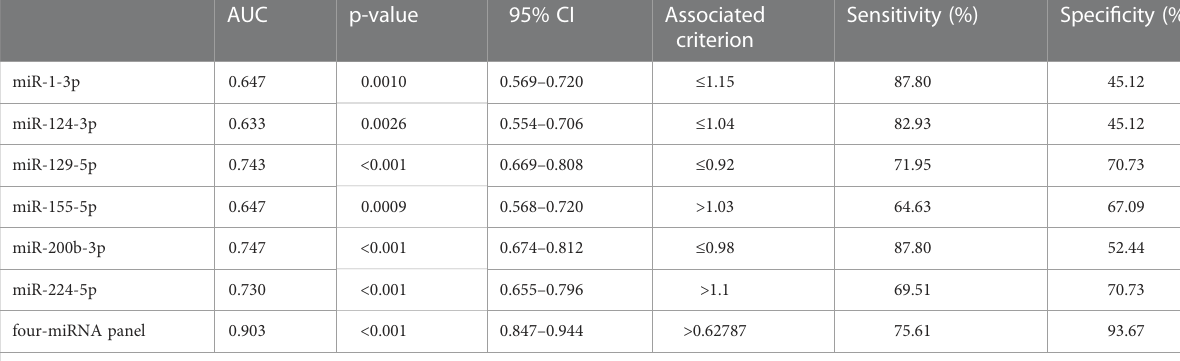
TABLE 2 Outcomes of receiver operating characteristic curves and Youden index for six candidate miRNAs and the panels. AUC p-value 95% CI Associated Sensitivity (%) Speci fi city criterion